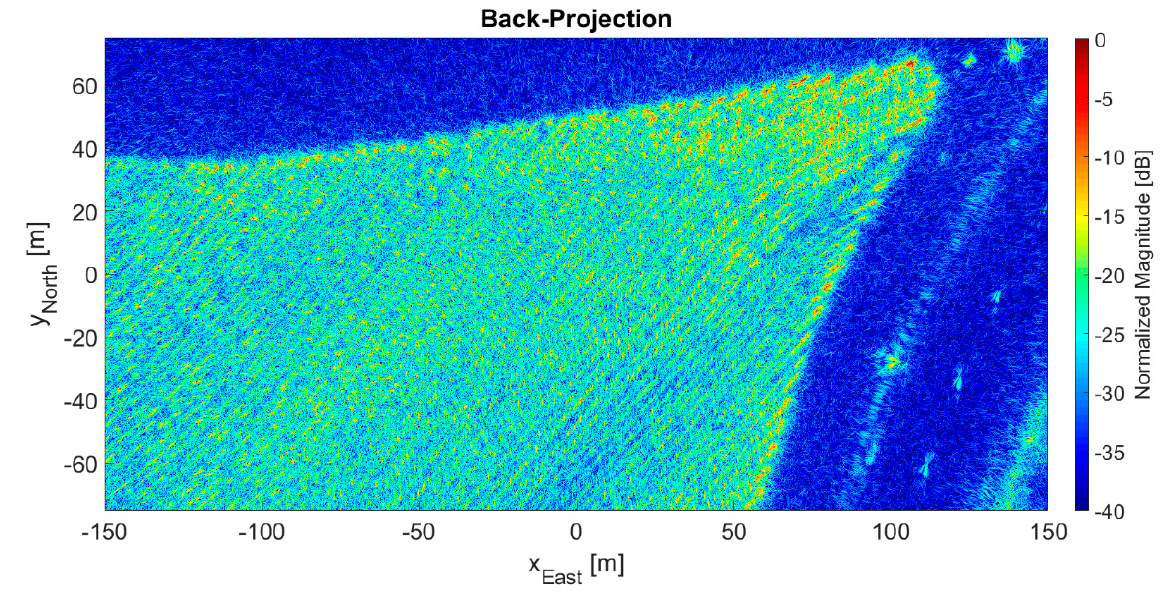
Figure 11. 2D output image processed by the BP algorithm.